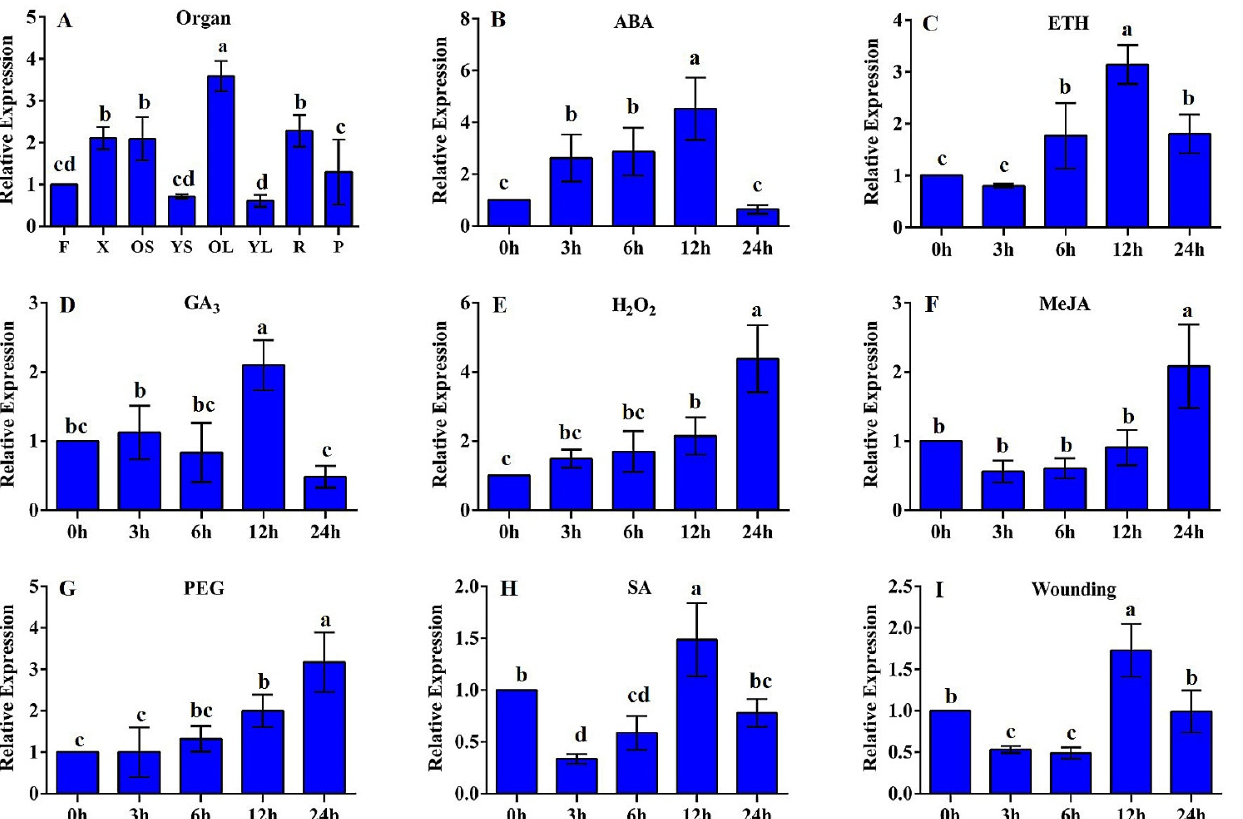
Figure 3. Expression patterns of the PmMYB7 gene as determined by RT–qPCR. ( A ) Expression levels in different organs/tissues. F, flowers; X, xylem; OS, old stems; YS, young stems; OL, old leaves; YL, young leaves; R, roots; P, phloem. ( B – I ) PmMYB7 expression levels in P. massonniana under different stress conditions. All the above treatments were added at 0 h, and no treatment was used for the control. Figure ( B ) shows the relative expression levels under 400 μ M ABA condi- tions; figure ( C ) shows the relative expression under 50 μ M ETH treatment conditions; figure ( D ) shows the relative expression under 2 mM GA 3 treatment conditions; figure ( E ) shows the relative expression under 10 mM H 2 O 2 treatment conditions; figure ( F ) shows the relative expression under 10 mM MeJA treatment conditions; figure ( G ) shows the relative expression under 15% PEG 6000 treatment conditions; figure ( H ) shows the relative expression under 1 mM SA treatment conditions; figure ( I ) shows the relative expression under wounding treatment conditions. The error bars repre- sent the standard deviation of three biological replicates. Means with different letters are significantly different at p <